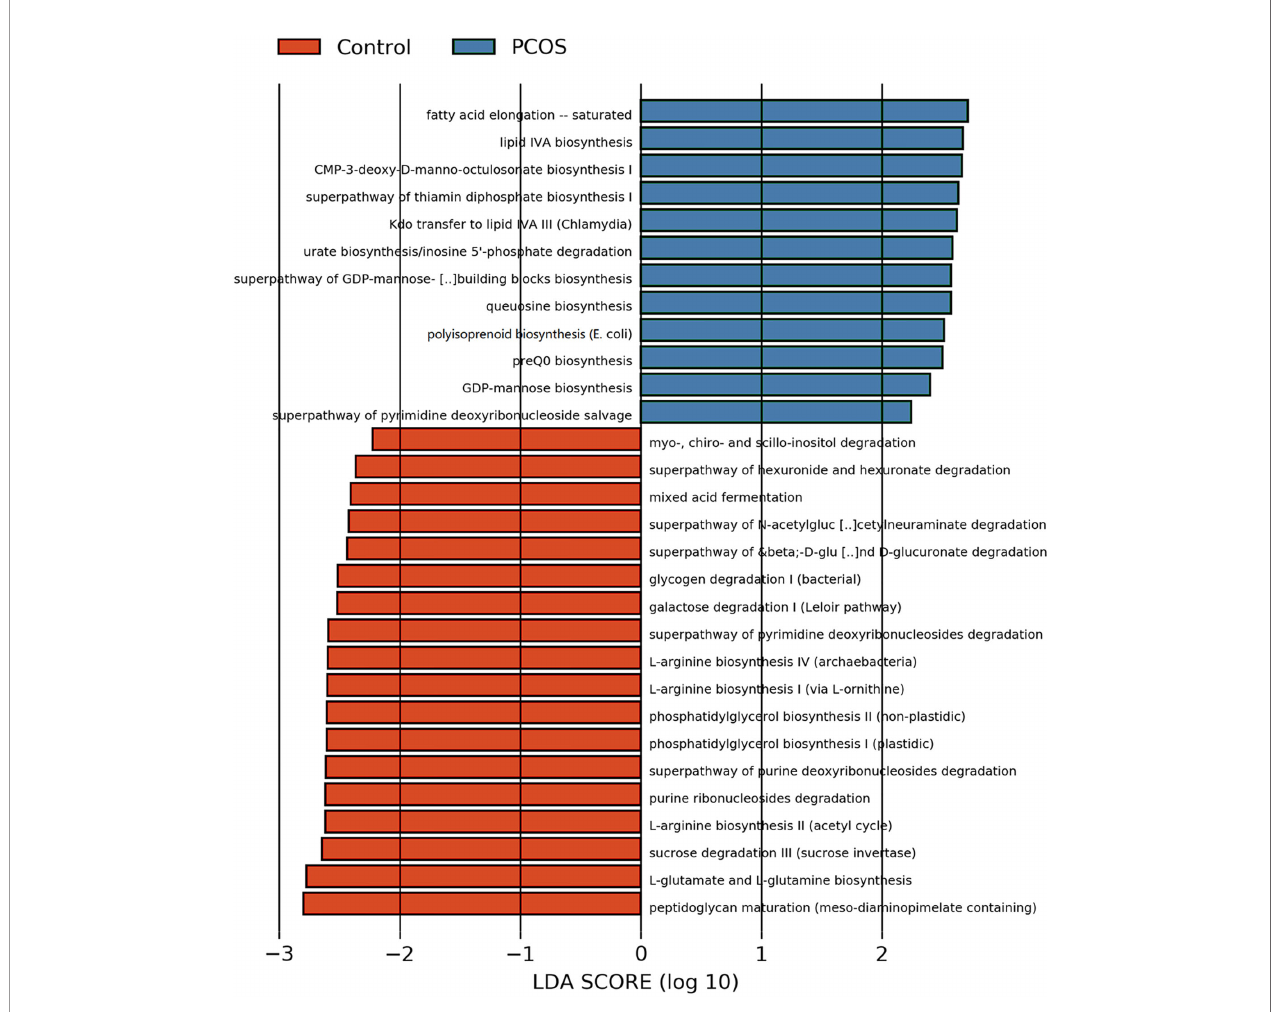
FIGURE 6 | LEfSe difference analysis based on functions in pathways. LEfSe, linear discriminant analysis effect